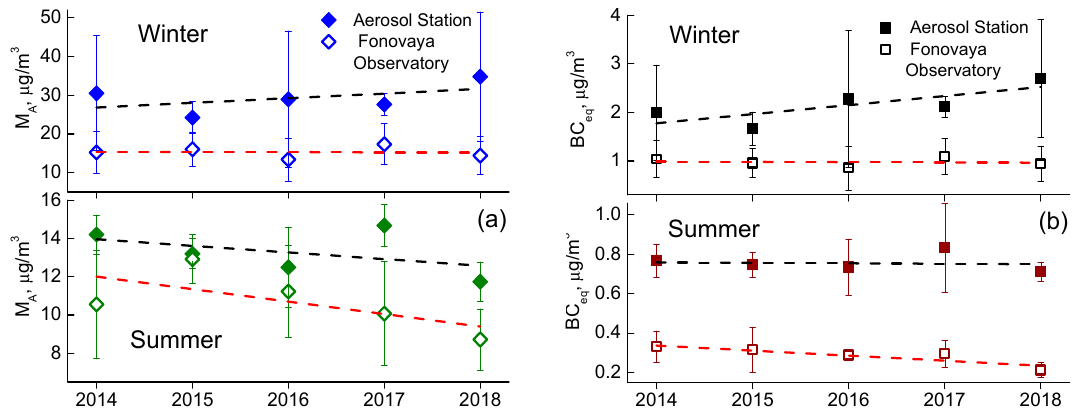
Figure 10. Multiyear behavior of annually average values and SD of ( a ) submicron aerosol and ( b ) BCeq concentrations at the Aerosol Station (suburban) and the Fonovaya Observatory (background) in 2014–2018. Closed diamonds show measurements at the Aerosol Station, open diamonds show measurements at the Fonovaya Observatory. Black dashed lines show trends at the Aerosol Station, and red dashed lines show those at the Fonovaya